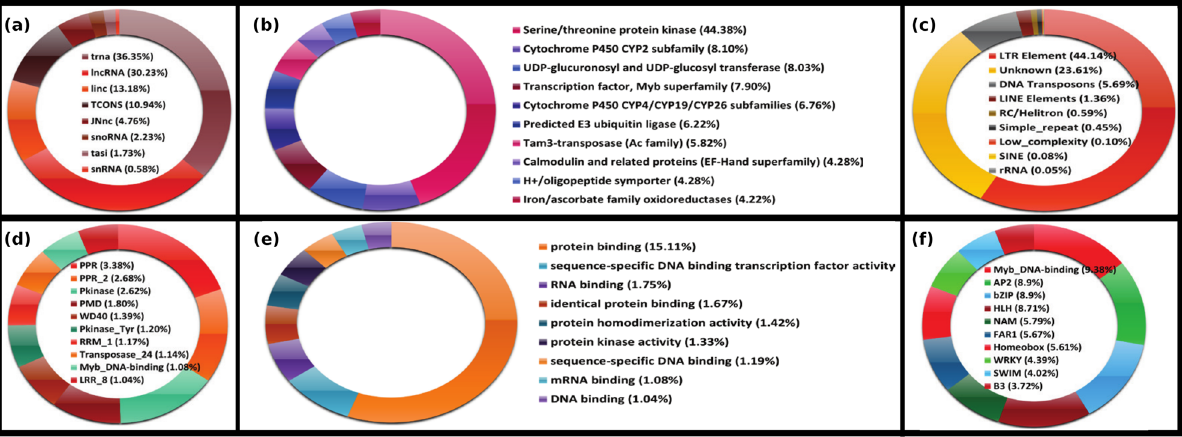
Figure 3. Top 10 categories from six different types of annotations ( a ) non-coding RNAs, ( b ) KOG, ( c ) repeats, ( d ) PFAM domain, ( e ) PFAM functional classification, and ( f ) transcription